Question: What does this figure show? Answer in one sentence.
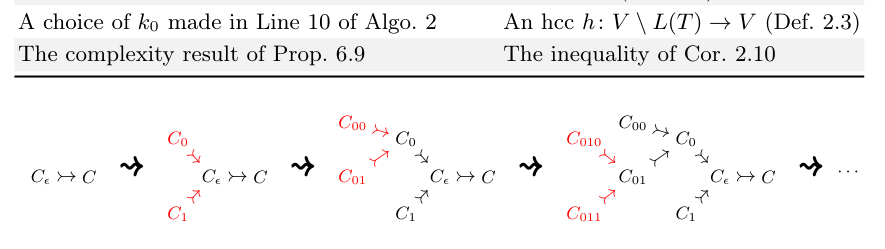
Answer: At each iteration one leaf of the tree is selected and refined.